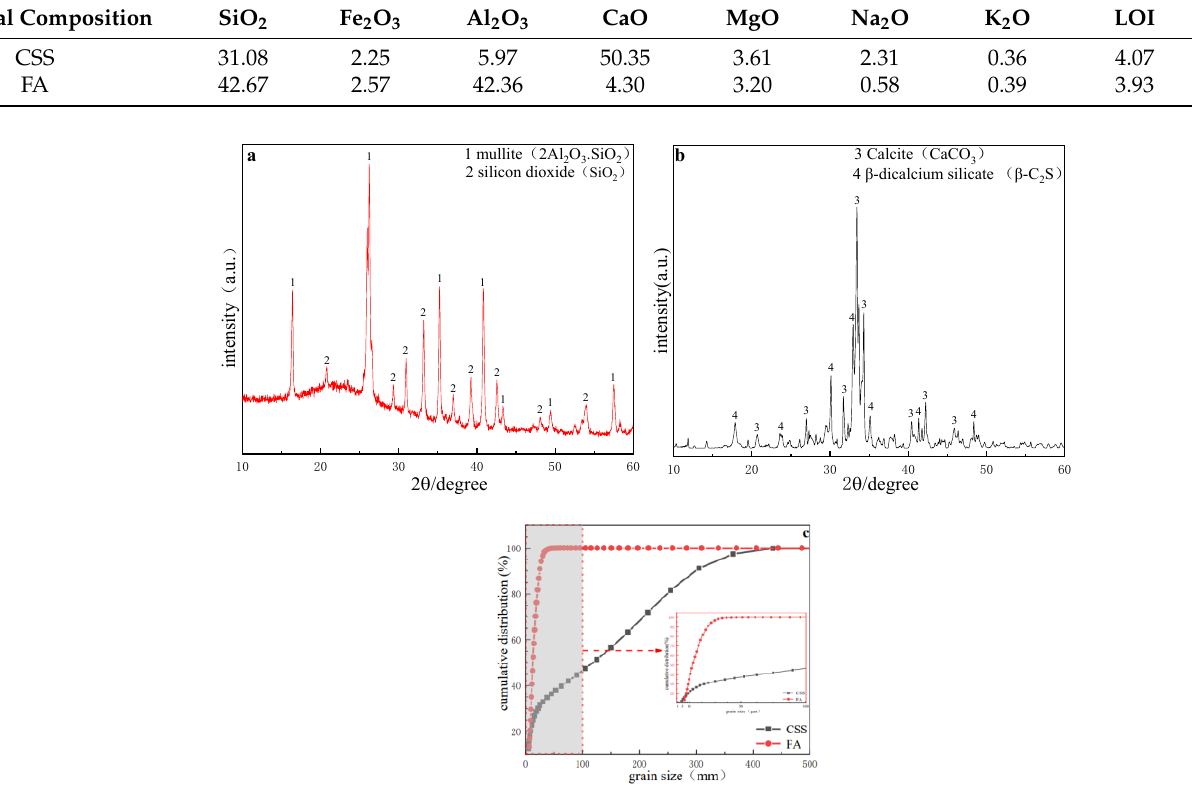
Figure 1. Characteristics of raw materials: ( a ) XRD pattern of CSS, ( b ) XRD pattern of FA, ( c ) size distribution of CSS and FA.